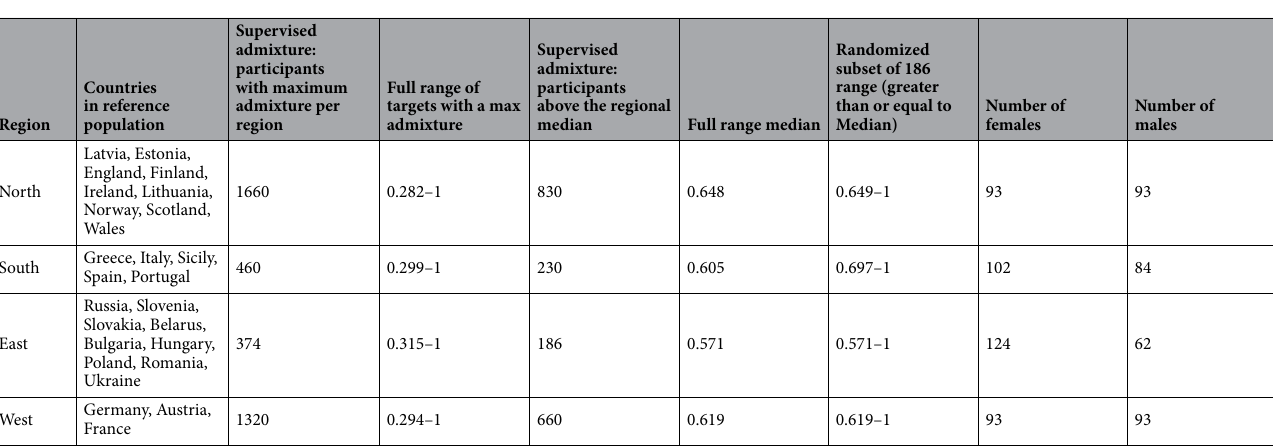
Figure 2. Regional assignment analysis for the participant data, ( A ) the distribution of admixture proportions for all samples assigned to the specific region based on their maximum ancestry proportion (n = 3814), ( B ) supervised ancestry proportions for the randomly selected participants (n = 186 per region) in each region above the median (observed in ( A )) where each bar is an individual’s ancestry proportions depicted by the color that total 100% and plotted with CLUMPAK 52 , ( C ) genetic principal components 1–4 of the four regions (n = 744), including an ellipse 53 estimated with the Khachiyan algorithm to depict the enclosed cluster. The square shapes represent the mean combination of both PCs for each region.